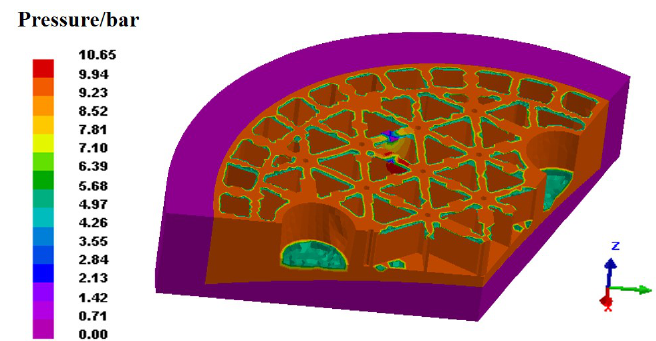
Figure 7. The pressure distribution after the filling process.